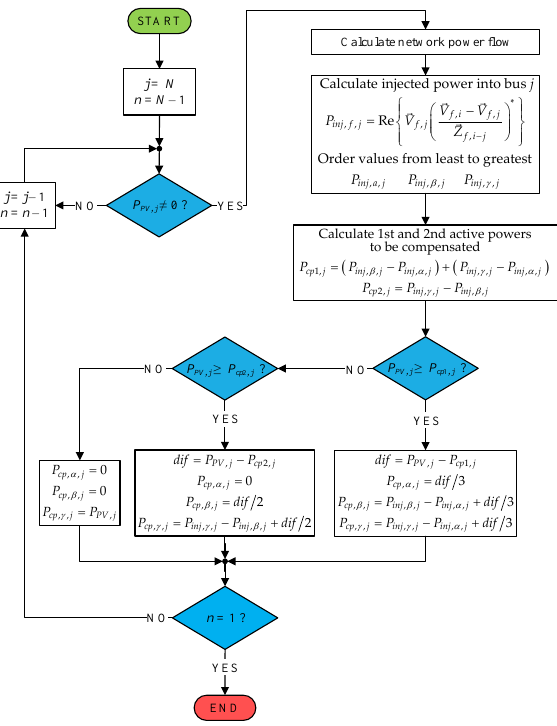
Figure 3. Flowchart for the phase imbalance compensation algorithm.